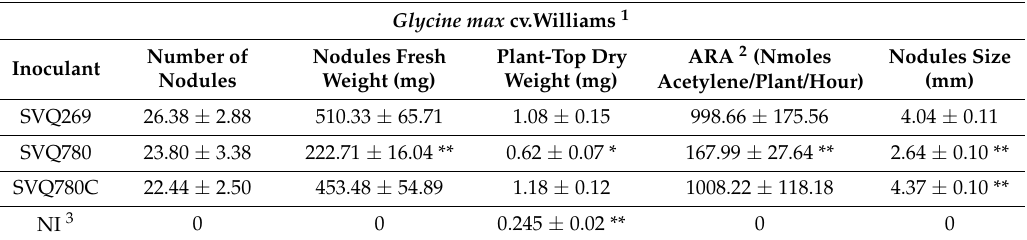
Figure 4. Symbiotic phenotype and nodule morphology of soybean plants inoculated with S. fredii SVQ269 (wt), its rirA derivative SVQ780 ( rirA ), and the complemented strain SVQ780C ( rirA C). Non-inoculated plants are denoted as NI. Scale bars next to nodules correspond to 1 mm. A representative example of at least two experiments is shown. Table 1. Symbiotic capacity of S. fredii SVQ269, its rirA (SVQ780) mutant derivative and the complemented version (SVQ780C) with Glycine max cv. Williams.